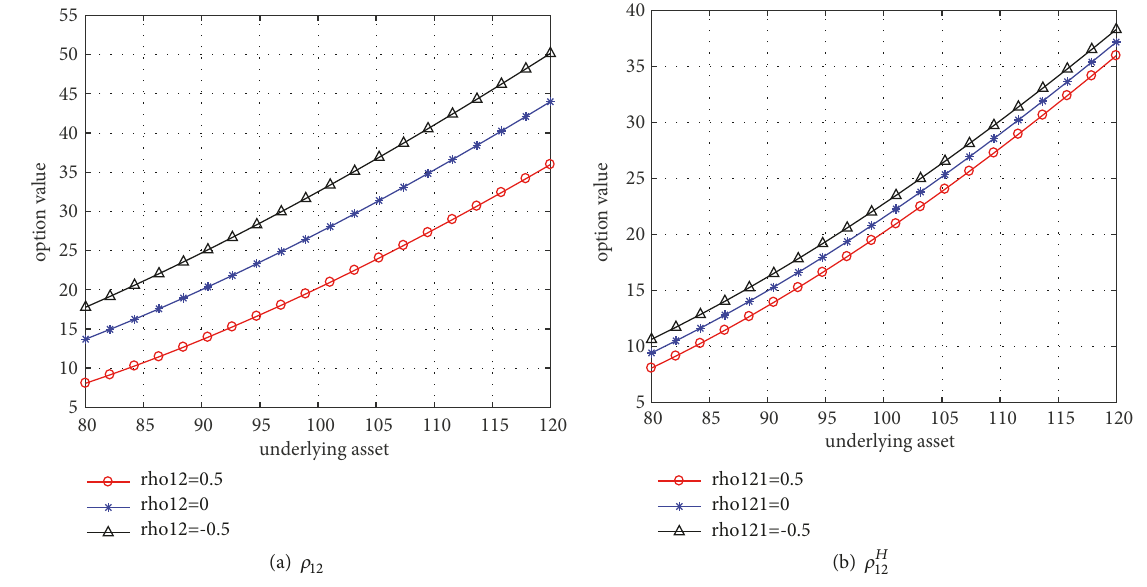
Figure 5: Change of option value under different correlation